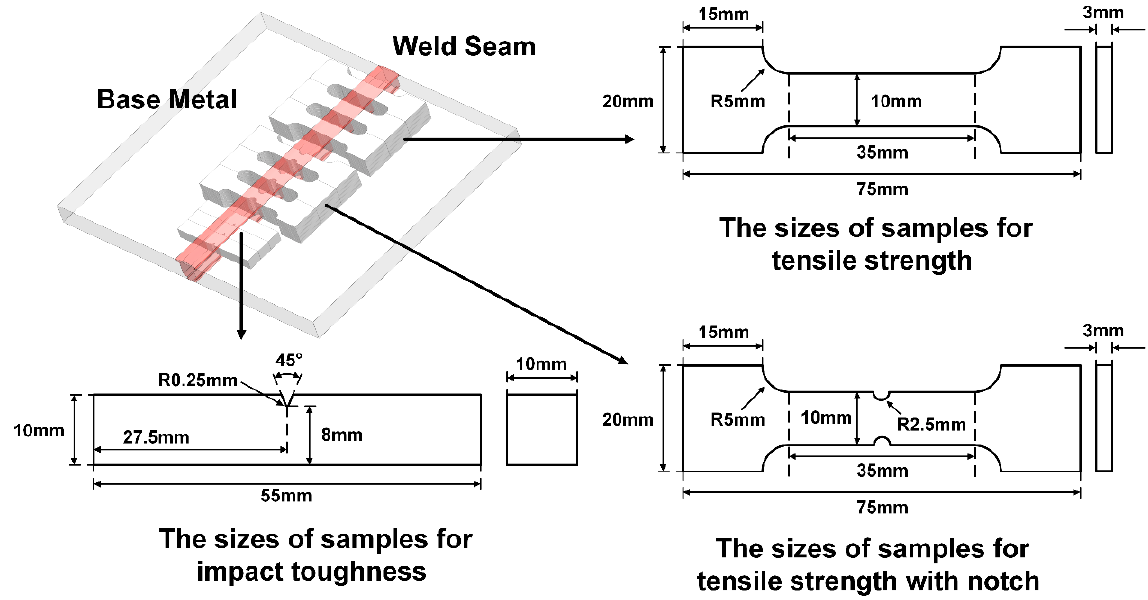
Figure 3. The specific sampling location and size of mechanical test parts.